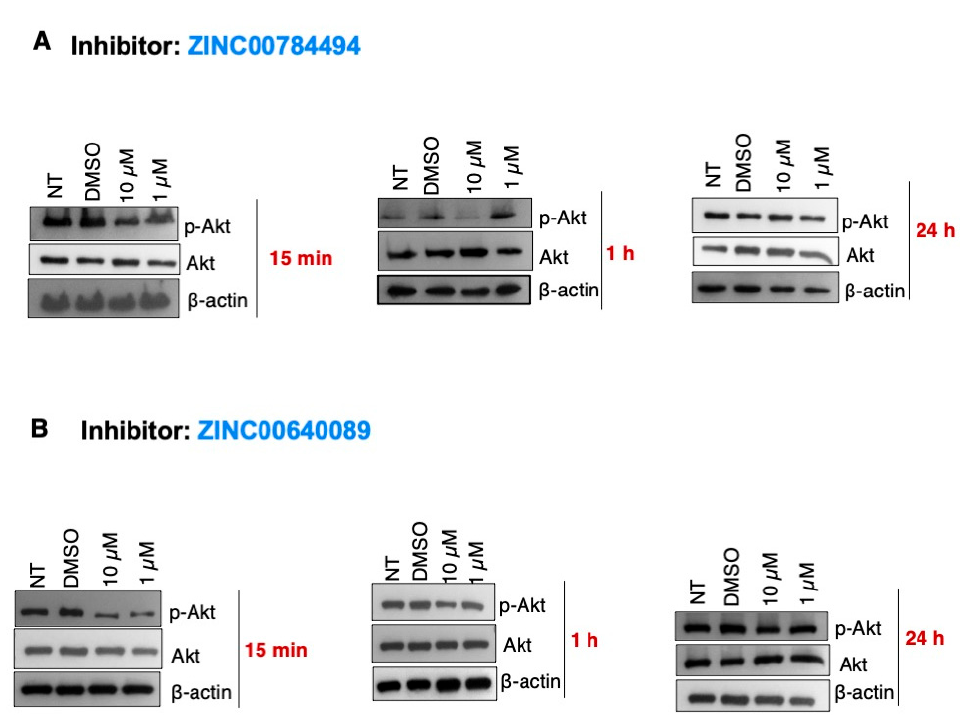
Figure 6. LCN2 inhibitors ZINC00784494 and ZINC00640089 reduced p-Akt in a dose-dependent manner in SUM149 cells. SUM149 cells were incubated with each inhibitor as described in the “mate- blot with specific antibodies against these protein forms. ( A ) ZINC00784494, ( B ) ZINC00640089. 2.7. LCN2-Inhibitors ZINC00784494 and ZINC00640089 Showed Specificity toward